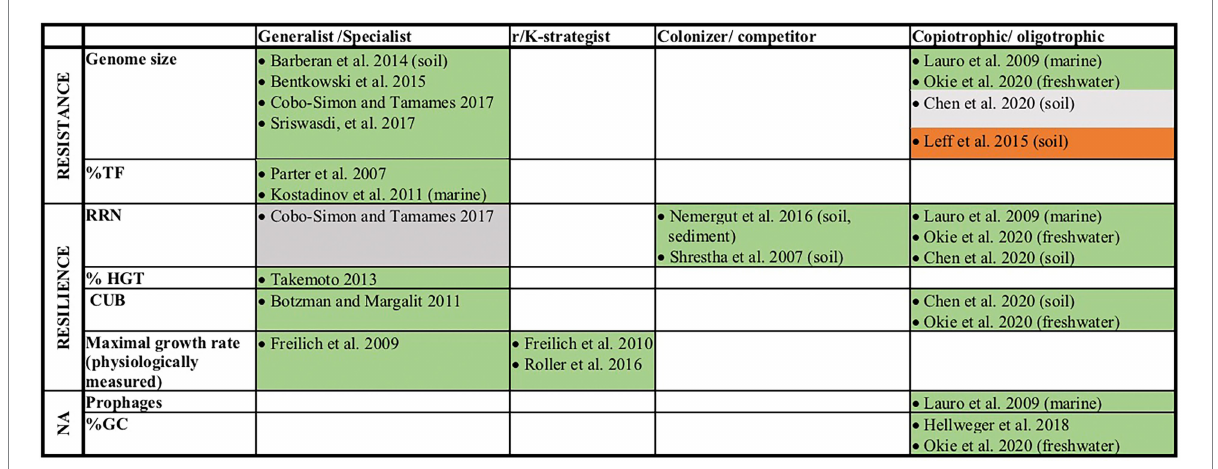
FIGURE 1 Overview of earlier literature that linked genomic traits or the physiologically measured maximal growth rates of prokaryotes to their life-history traits. Traits that were in this study assigned as resistance or resilience related traits are indicated. If studies refer to organisms from a specific ecosystem, this is given in brackets. Green (or red) fields indicate studies that found positive (or negative) relationships ( p < 0.05) between the listed genomic feature and a life style as generalist, r-strategist, colonizer or copiotroph. In one study no value of p was reported, but mathematical evidence for increased environmental tolerance of species with large genomes was provided via the computational simulation of evolutionary processes (Bentkowski et al., 2015). Gray fields indicate studies where neither a significant relationship and not even a positive or negative trend was detected ( p >